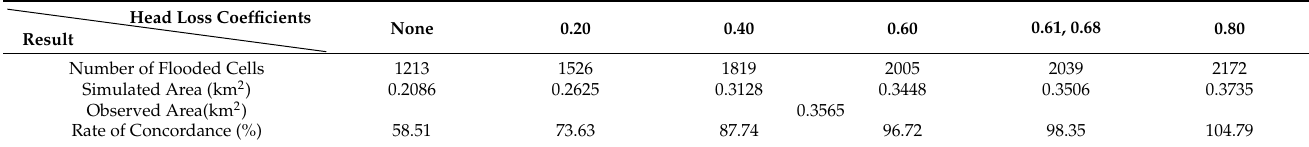
Table 6. Change of inundation area by the application of head loss coefficients (Dorim